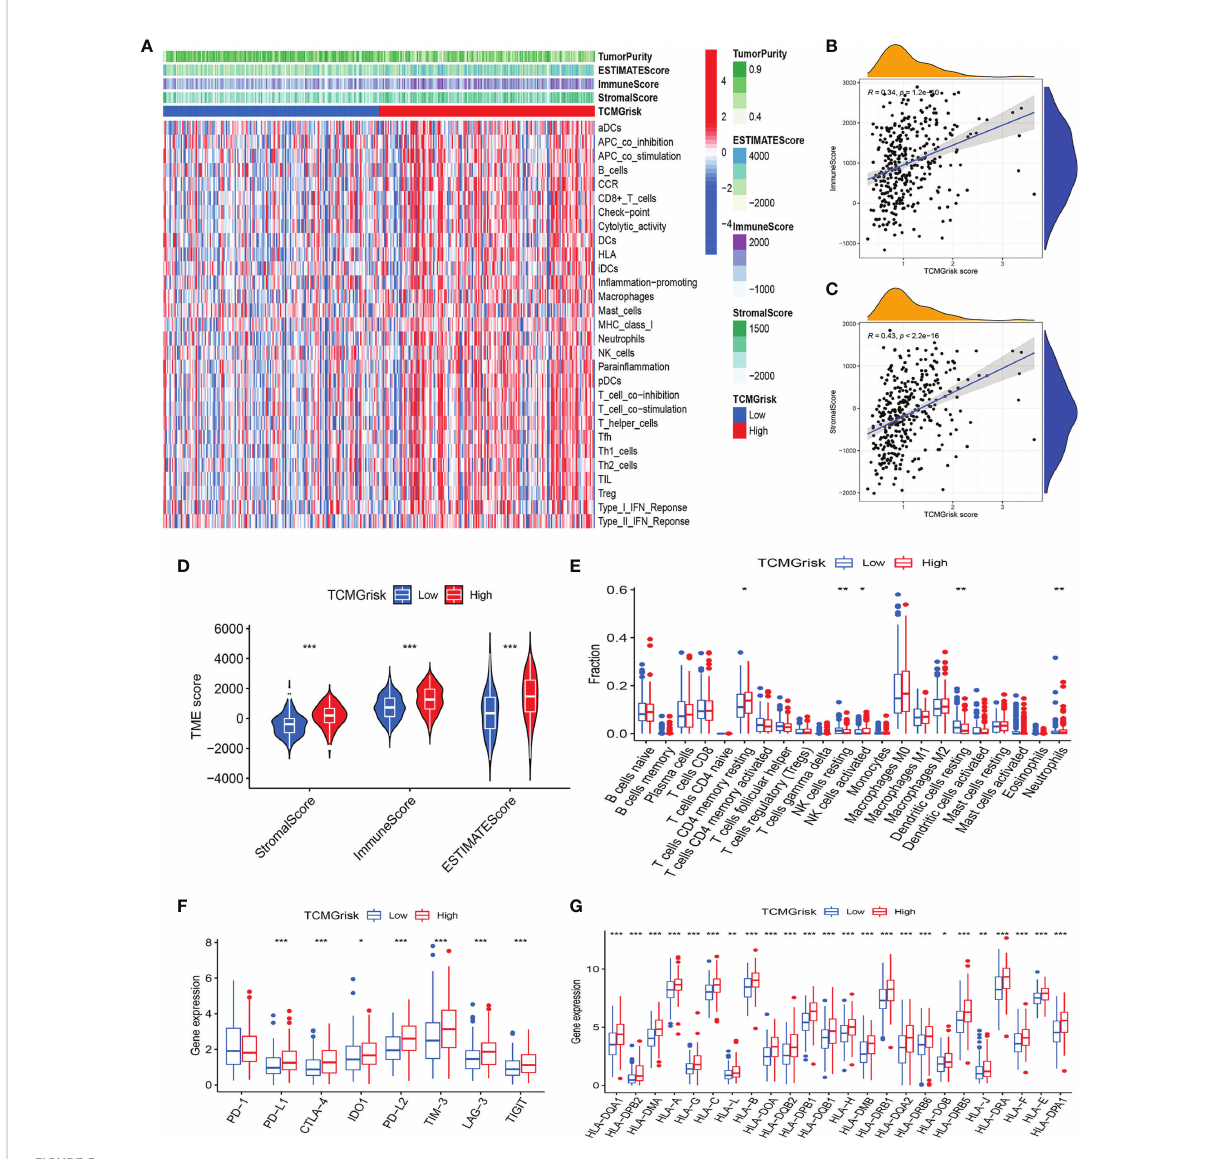
FIGURE 5 Characteristics of tumor immune microenvironment. (A) Heatmap showed the relationship between TCMGrisk and 22 immune-related functions. (B) Correlation between TCMGrisk and immune score. (C) Correlation between TCMGrisk and stromal score. (D) Differences expression levels of stromal, immune, and ESTIMATE scores between low-risk and high-risk groups. (E) Difference expression levels of 22 types of tumor-in fi ltrating immune cells between low-risk and high-risk groups. (F) Differential expression levels of the immune checkpoint-related genes between low-risk and high-risk groups. (G) Differential expression levels of the human leukocyte antigen-related genes between low-risk and high-risk groups. *** P < 0.001, ** P < 0.01, * P <